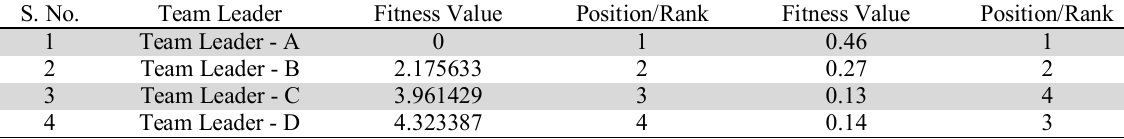
Comparative Rankings obtained from EDBA and AHP S.